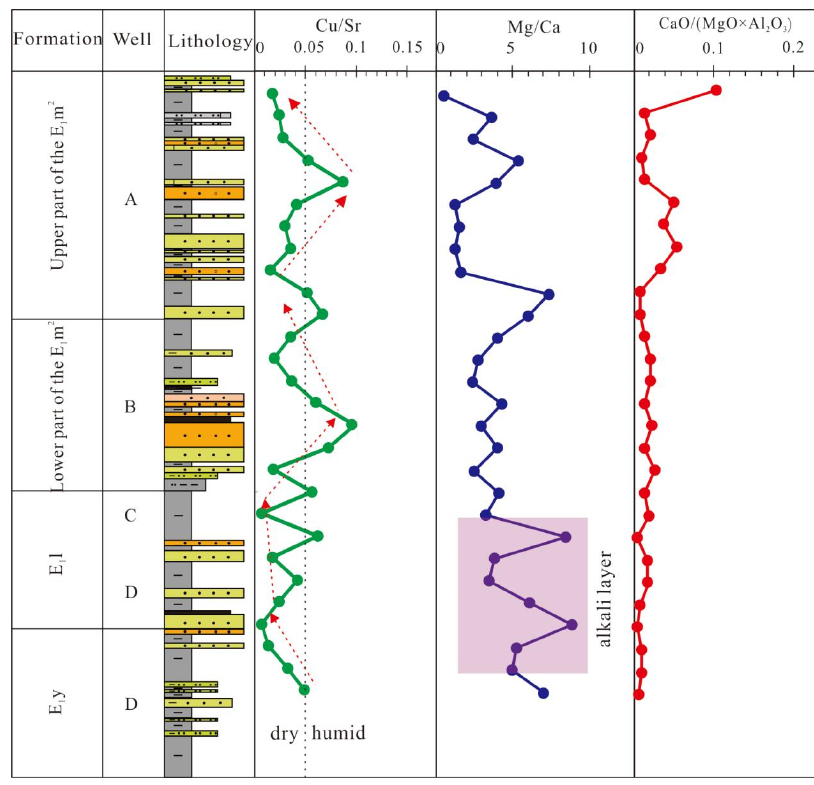
Figure 9. A comprehensive evolution section of paleoclimate in the West Lishui Sag.